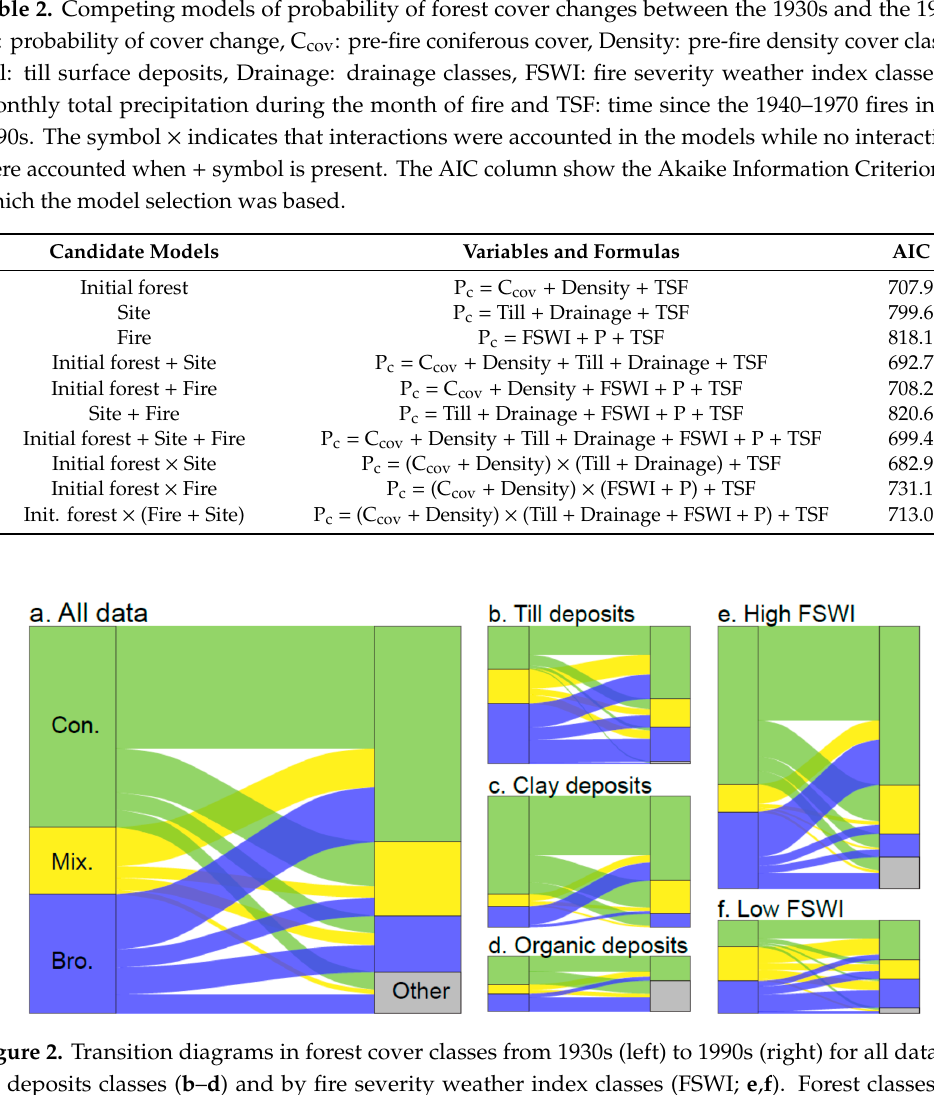
Table 2. Competing models of probability of forest cover changes between the 1930s and the 1990s. P c : probability of cover change, C cov : pre-fire coniferous cover, Density: pre-fire density cover classes,